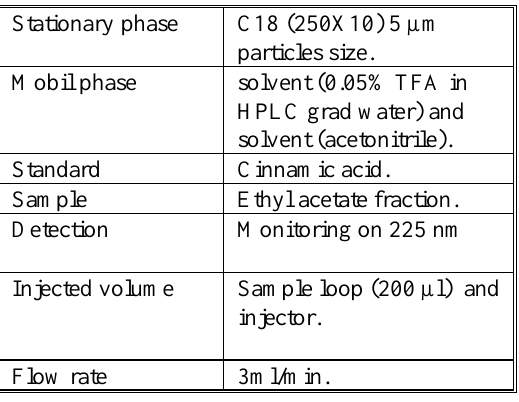
Table 1 . Conditions of analytic HPLC (29) .